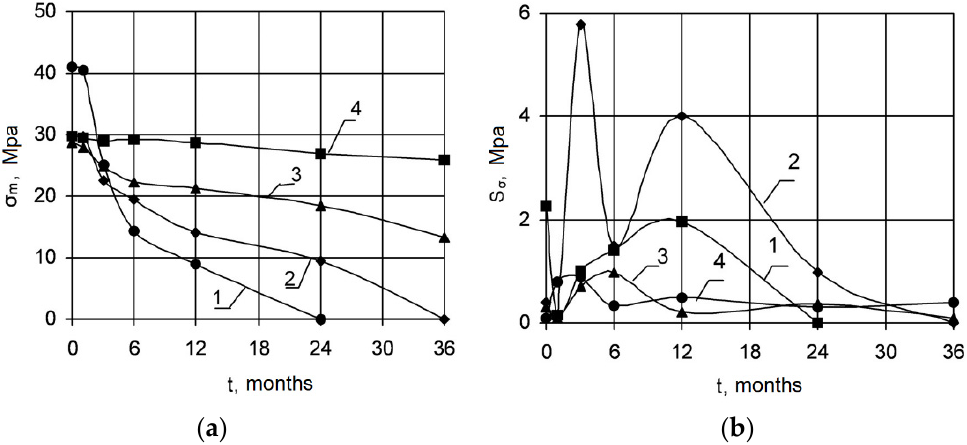
Figure 5. Dependence of ( a ) the average value and ( b ) the standard deviation of the yield strength on the aging time in cold climate conditions for the BSPE 22007-16 material. The cross-sectional areas of the samples: (1) 1 × 2.5; (2) 2 × 5; (3) 3 × 13; (4) 8 × 25 mm 2 . Due to the fact that the solar radiation effect changes the structure in the surface layers of the samples, the effect of this process on the material during natural aging should depend on the thickness of the samples. Indeed, for the colorless materials of the block copolymer of propylene with ethylene BSPE 22007 and frost-resistant polypro-